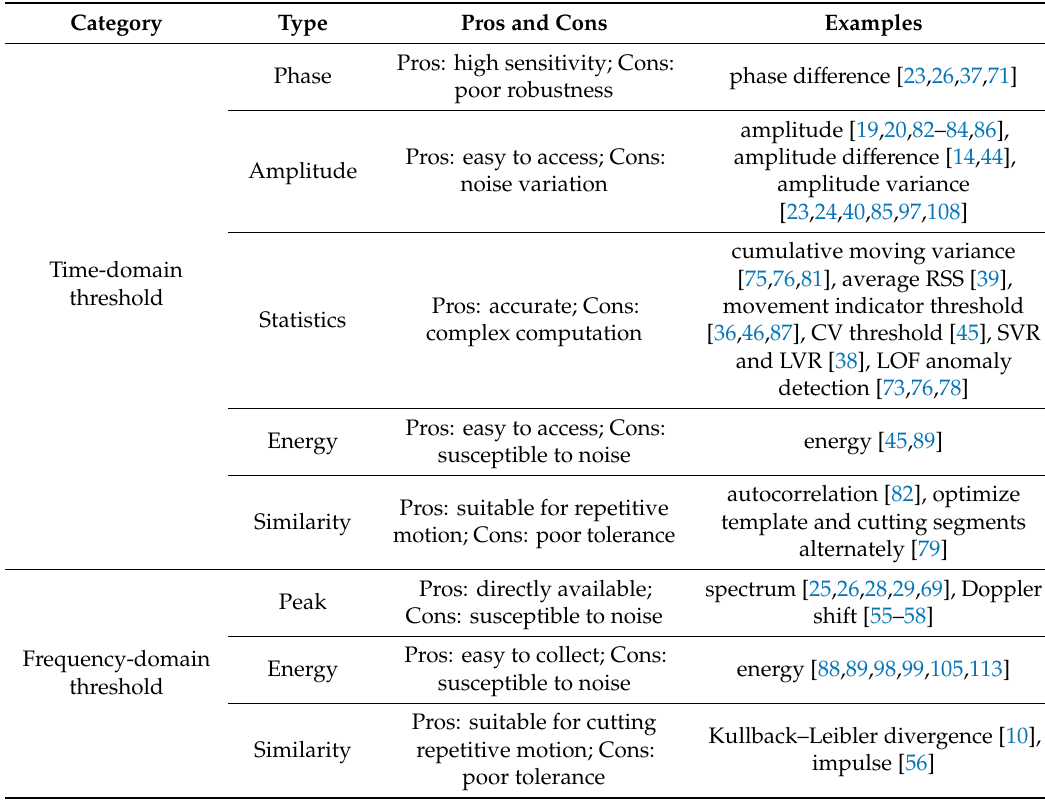
Table 6. Summary of signal